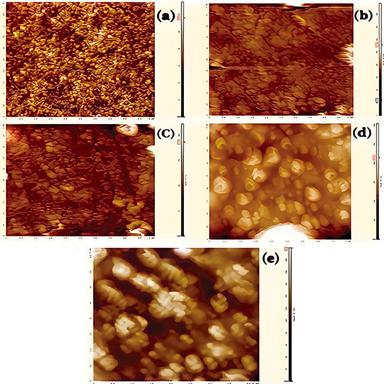
AFM micrographs of (a) Pure (b) 1 wt% (C) 5 wt% (d) 10 wt% (e) 15 wt% Cu doped NiO thin films.